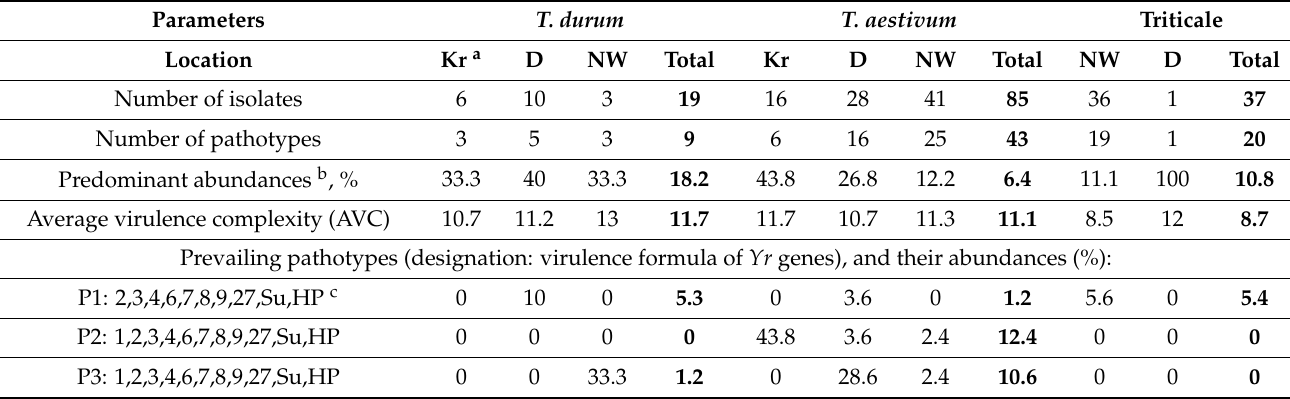
Table 2. Pathotypes of P. striiformis identified among isolates originating from wheat and triticale in three Russian regions.